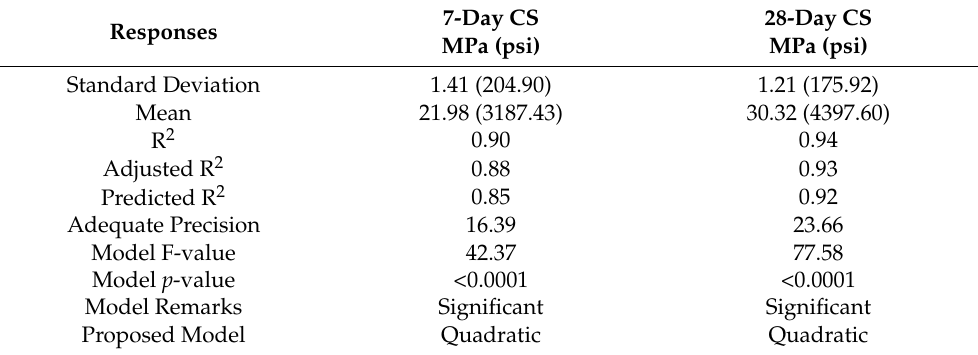
Table 6. ANOVA and fit statistics of compressive strength.